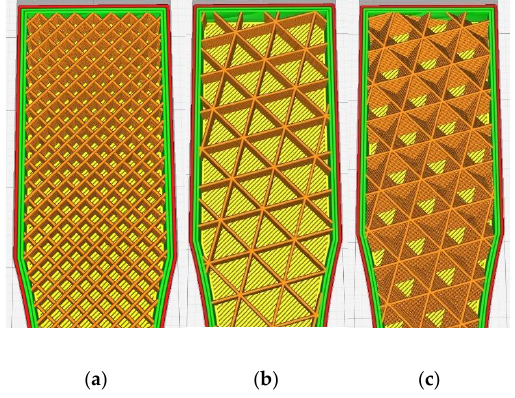
Figure 3. Examined infill patterns: ( a ) lines, ( b ) triangles, and ( c ) cubic.